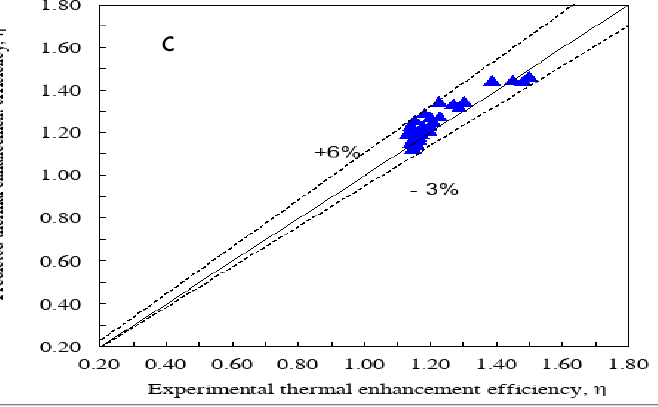
Figure 3: Comparison between the predicted and experimental data (a) Nusselt number (b) Friction factor (c) Thermal enhancement efficiency [11].